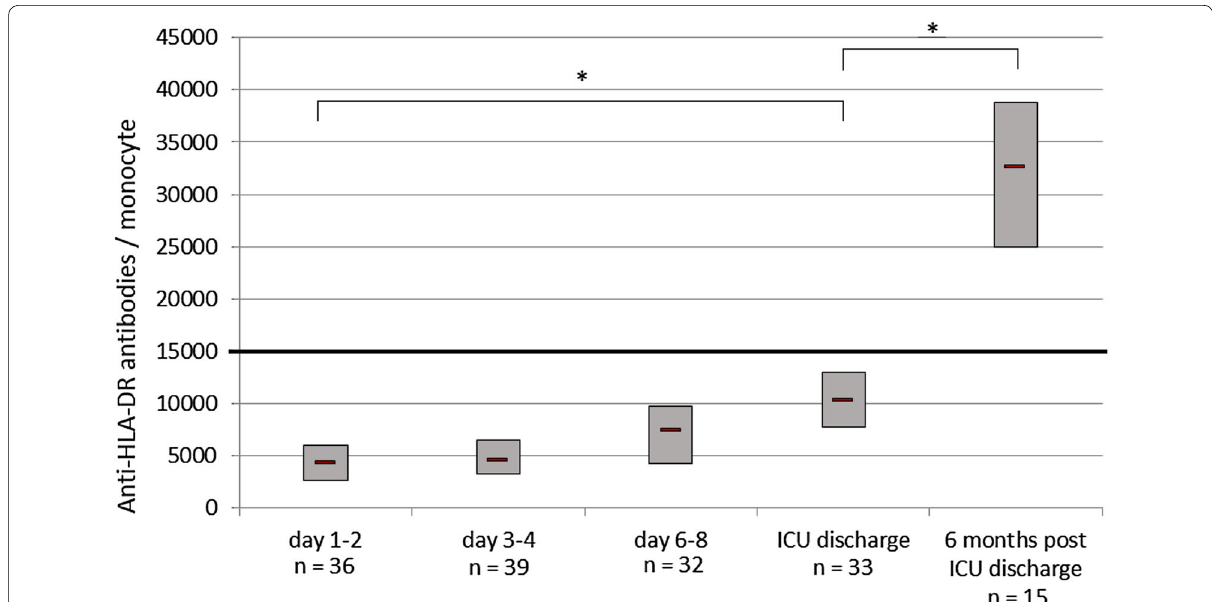
Fig. 2 mHLA-DR expression from day 1 after admission to ICU discharge. Box plot interpretation: box borders: 1st and 3rd quartile, central band in box: median value, *significantly